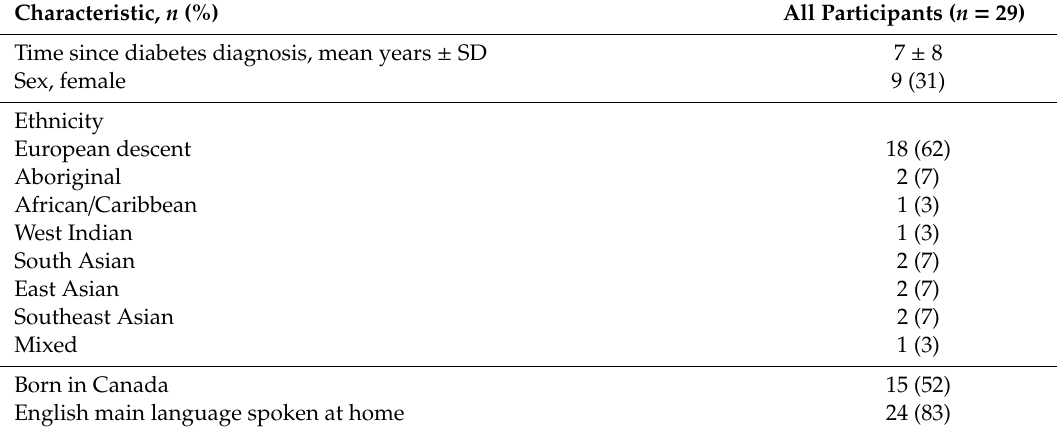
Table 1. Participant demographic and clinical characteristics (Glycemic Index Questionnaire (GIQ) Section